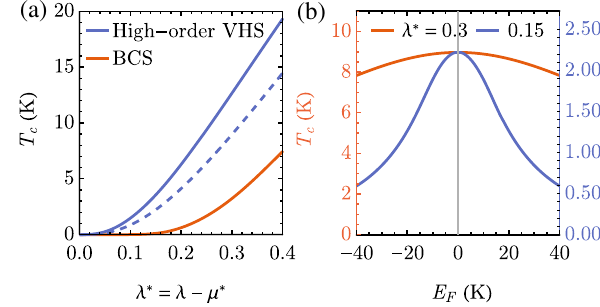
FIG. 4. (a) Transition temperature T at different effective c 80 K and ν ¼ − 1 = 3 (the chemical interaction λ (cid:1) with ϵ D ¼ potential is at the high-order VHS). The Anderson-Morel plot refers to the original Anderson-Morel formula T c ¼ 1 . 13 ϵ exp ð − 1 = λ (cid:1) Þ [22], and the high-order VHS plot refers to D Eq. (10). The solid blue line corresponds to Λ ¼ ϵ and the D = 2 ; in either case, T dashed line corresponds to Λ ¼ ϵ with a D c high-order VHS is much higher than the one without, especially when the effective interaction λ (cid:1) is small. (b) Transition temper- ature T when the chemical potential E is not exactly at the high- c F = 2 . The red axis on the left and order VHS energy with Λ ¼ ϵ D the blue axis on the right correspond to the red and blue curve, respectively, both of which are T in kelvin. T starts to drop c c when E is comparable to T F c